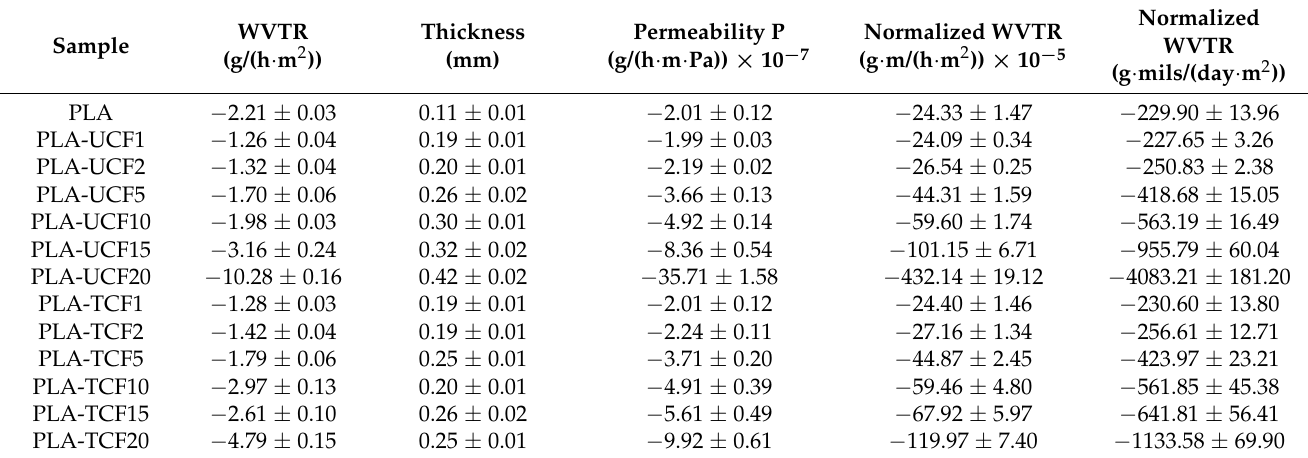
Figure 3. WVTR of the films with varying CF concentration. Table 2. Vapor permeability results of the Table 2. Vapor permeability results of the films.